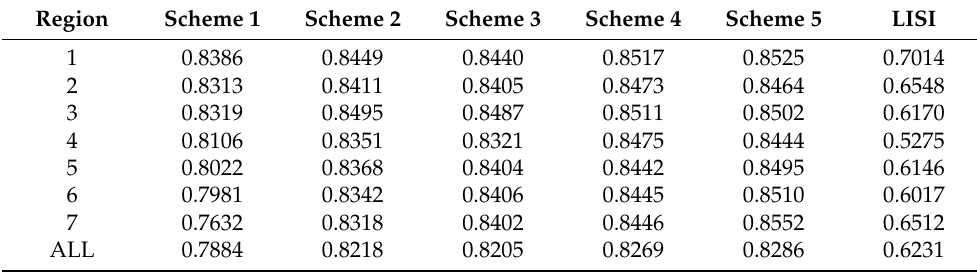
Figure 7. Spectral curves of impervious surface percentage for time-series image synthesis method (mean value and standard deviation). Table 3. Results of feature set combinations in different regions (R 2